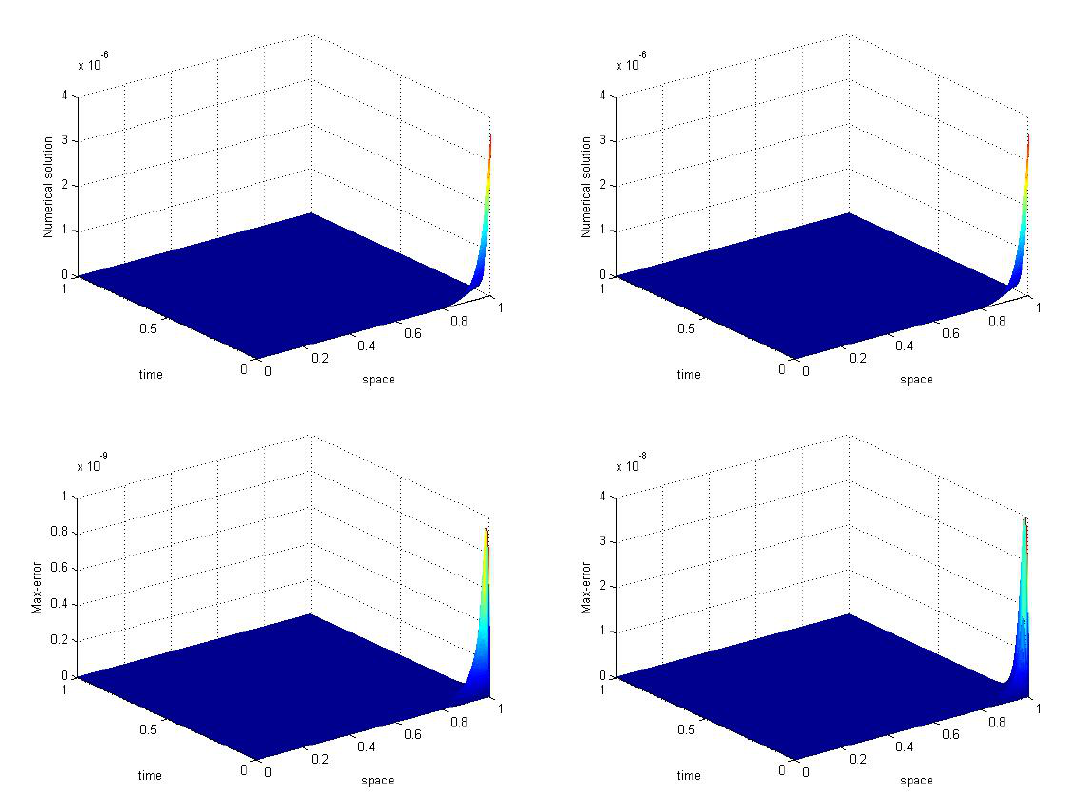
Figure 9. Numerical solution and max-error using modified FVM ( Left ) and central scheme of FVM ( right ) for right for convection dominance taking v = 2, k = 0.001 ( ∆ t = 1/3000, ∆ x = 1/320 for numerical example 3).